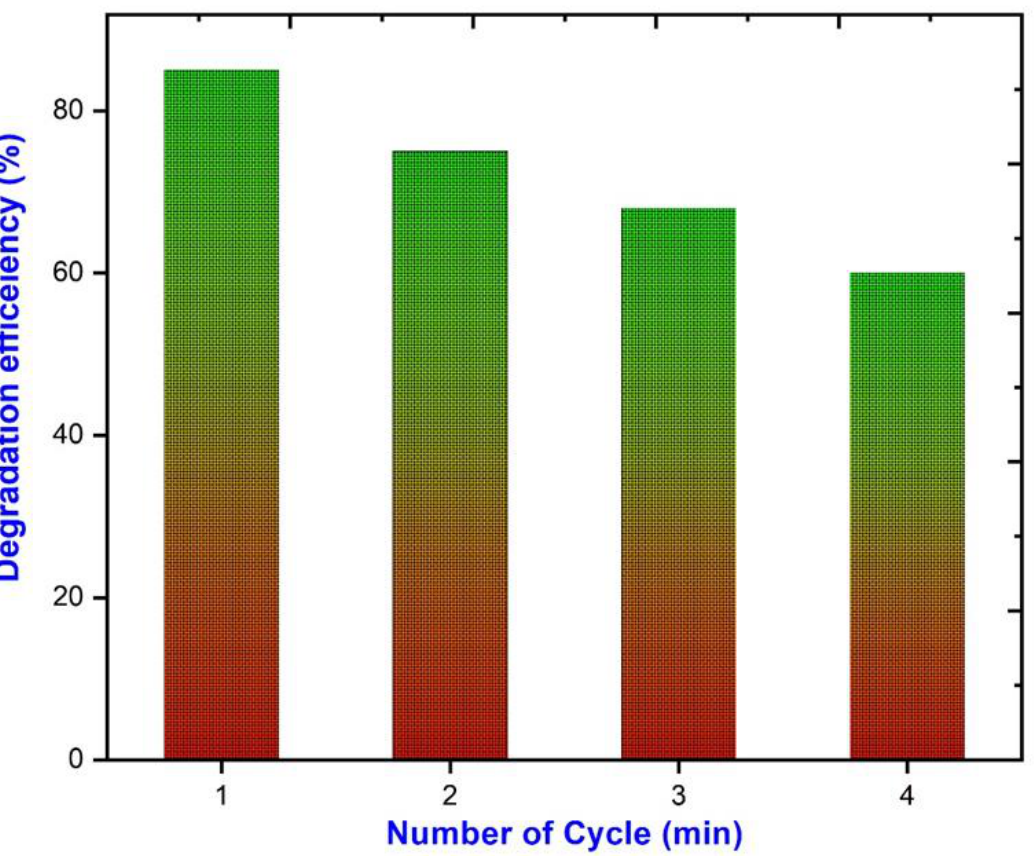
Figure 8. Photocatalytic degradation efficiency bar diagram of MnO 2 doped with Ag nanoparti- cles.